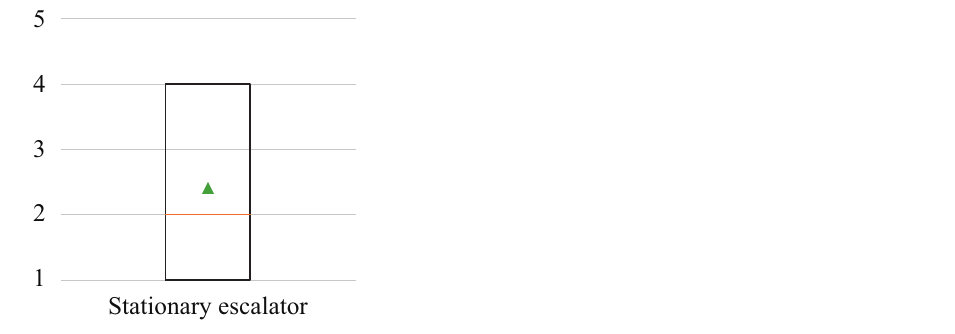
Figure 15. Result of the questionnaire “The AR escalator looked like the real